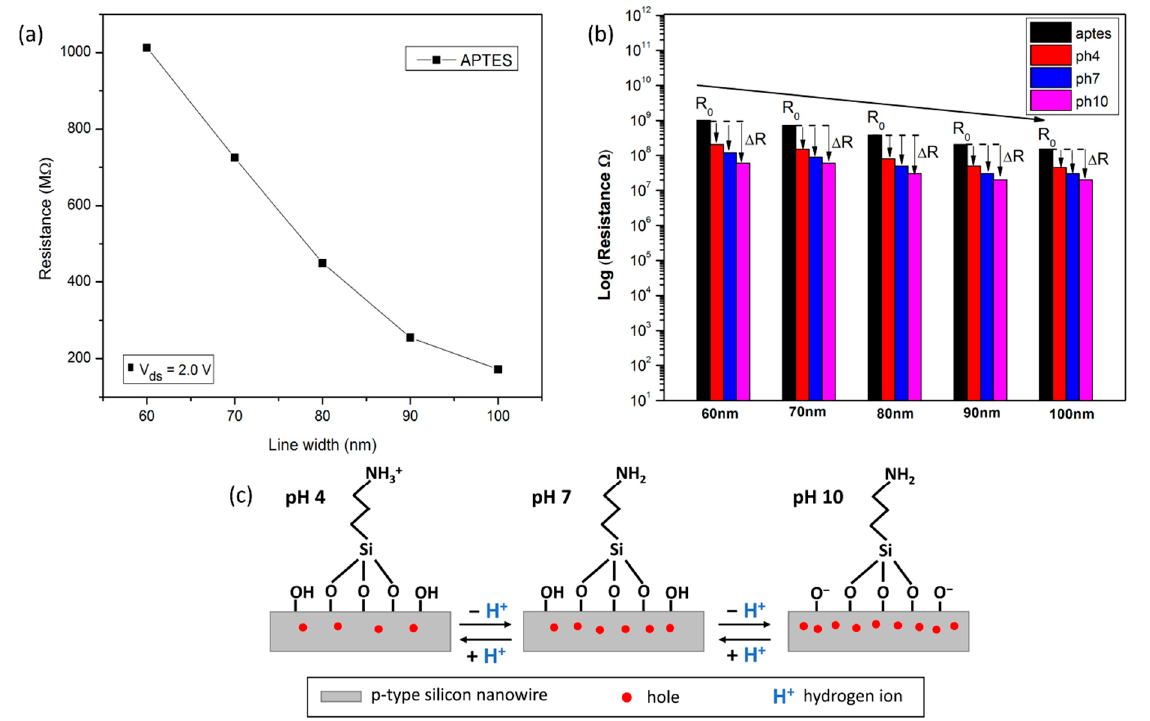
Figure 5. ( a ) The average resistance measurement of sensor devices dependent on the width of SiNW in response to the APTES modified. ( b ) The current response of fabricated devices with different widths of SiNW for pH level detection (i.e., pH 4, 7, and 10). ( c ) The underlying mechanism of the p-type SiNW for pH sensing.